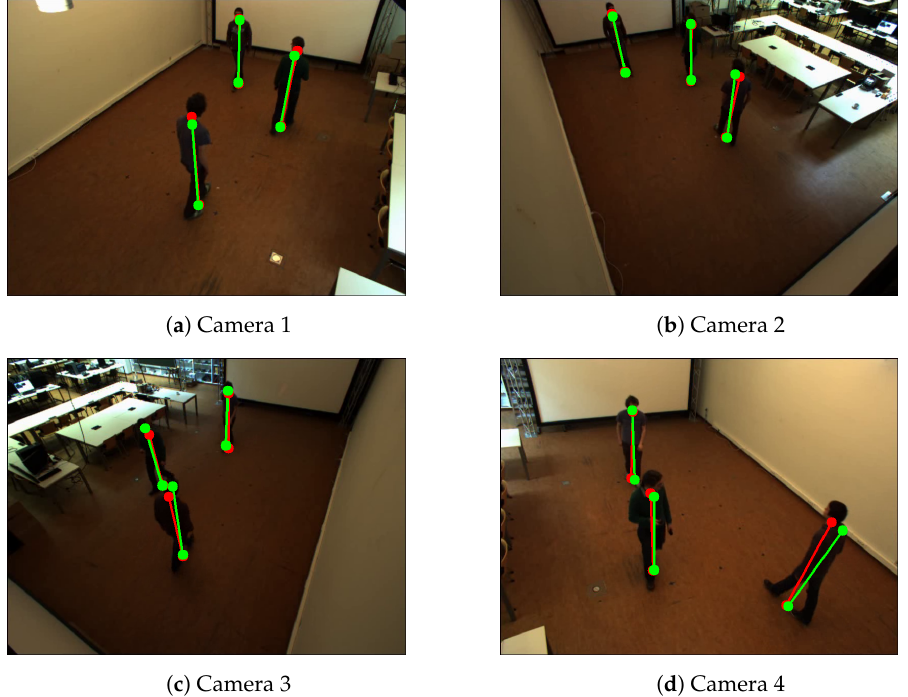
Figure 6. Example of detected the bottom and top positions of the pedestrians of Camera Network 1—multiple people walking in an empty room. Red color represents detected positions by the human pose estimation method. Green color represents the detected reprojected positions.